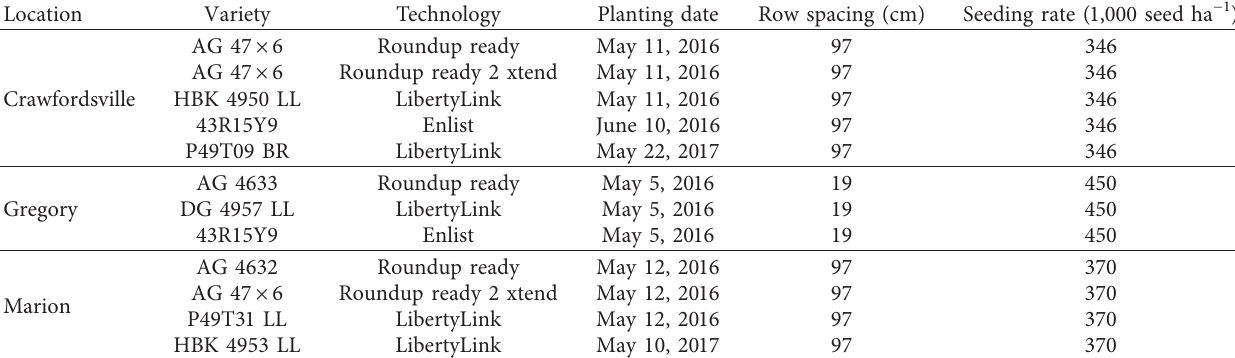
Abbreviations: AG, Asgrow, Bayer CropScience, Research Triangle Park, NC 27709; DG, Delta Grow, Delta Grow Seed, England, AR 72046; HBK, Hornbeck, Hornbeck Seed Company, De Witt, AR 72042; P, Pioneer, DowDupont Midland, MI 48674; 43R15Y9, Enlist soybean variety designation, Corteva, Midland, MI 48674.